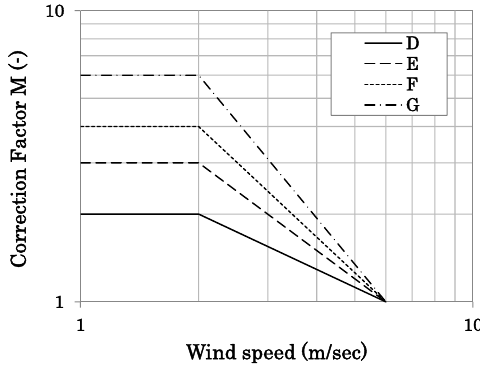
Figure 11. Correction factor, M1 , defined by the U.S. Nuclear Regulatory Guide (NUREG) 1.145 [19]. In the Mt. Tsukuba field experiments, the variance of wind direction was measured over the concentration sampling time (30 min.) by an ultrasonic anemometer, lifted by a balloon to the same height as the gas release, as shown in Table 1. The data were analysed to obtain the meandering factor, M 2, from Equations (4) and (5); the standard 3-min average deviation of wind direction (cid:2026) (cid:3087)(cid:2871) was not observed, so it was calculated from the 3-min average lateral plume spread (cid:2026) (cid:3052)(cid:2871) at 1000 m on the Pasquil chart in Figure 7. The meandering factors M 2, were found to be much